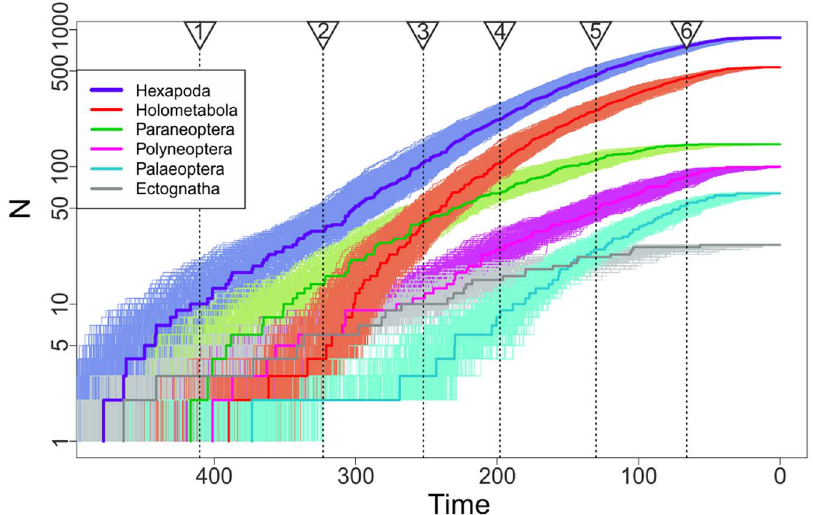
Figure 2. Lineage (y-axis; log scale) through time (x-axis; Ma) plot for the major groups of Hexapoda using the phylogeny in Fig. 1. Colors used identify the same clades as the ring in Fig. 1. Thick lines are calculated from the mean tree dates (Fig. 1). Shaded regions represent 500- scaled samples taken from the MCMC chain used in dating. Major events in the history of the group are denoted using dotted lines: 1. Oldest Hexapod fossil. 2. Oldest member of crown Pterygota (Polyneoptera). 3. Permo-Triassic mass extinction. 4. Origination of crown Angiosperms [44]. 5. Angiosperms become abundant in fossil record. 6. Cretaceous-Paleocene mass extinction.